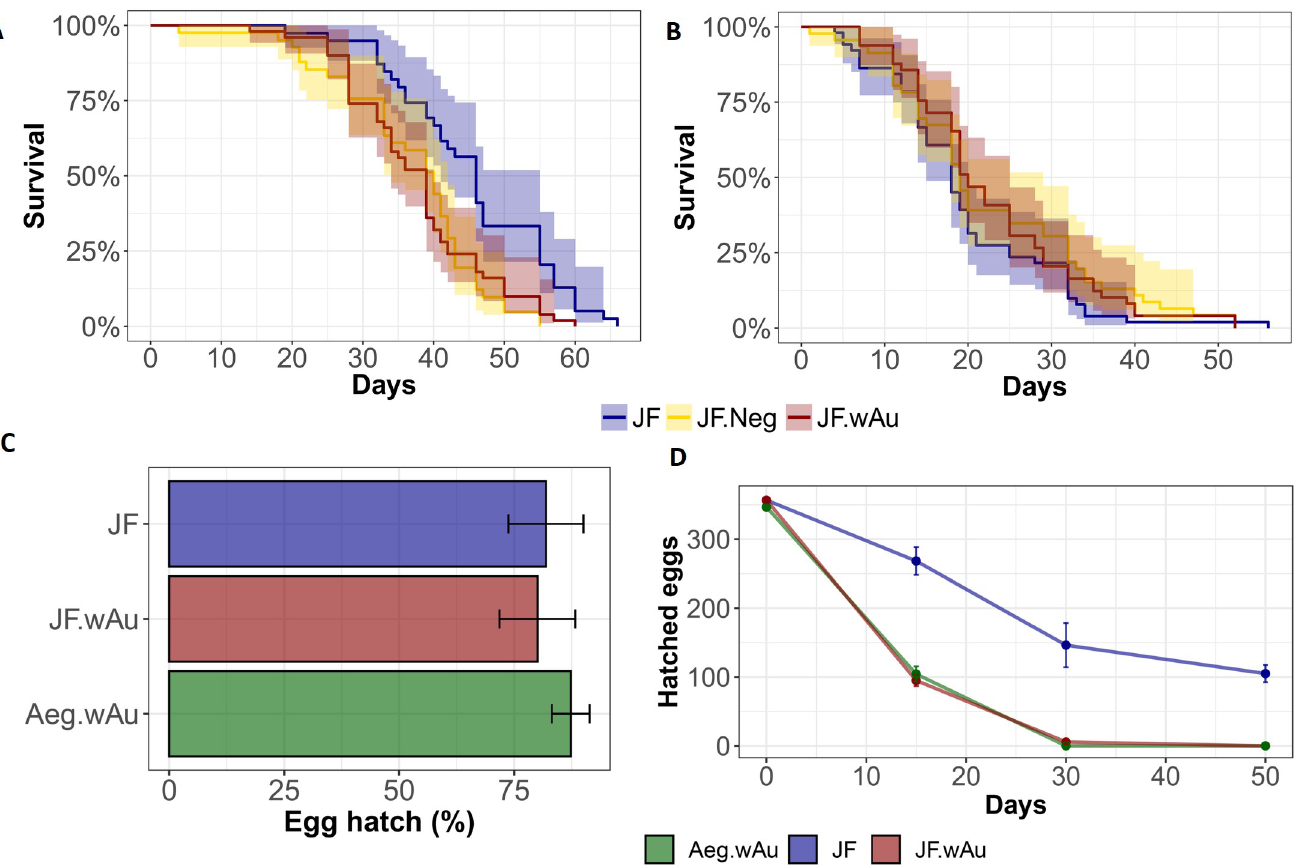
Fig 2. Fitness traits characterization. A-B) Females and males life span of JF, JF.wAu and JF.Neg was measured and compared using proportional hazard ratio model (Log-rank—Mantel-Cox test). C) Fecundity of lines determined by counting the number of eggs from individual females. SE is indicated. One-way ANOVA with Bartlett’s test was used for measuring statistical differences. D) Mean hatching rate over time. Statistical differences between datasets was measured using Two- way ANOVA with Dunnett’s comparison.